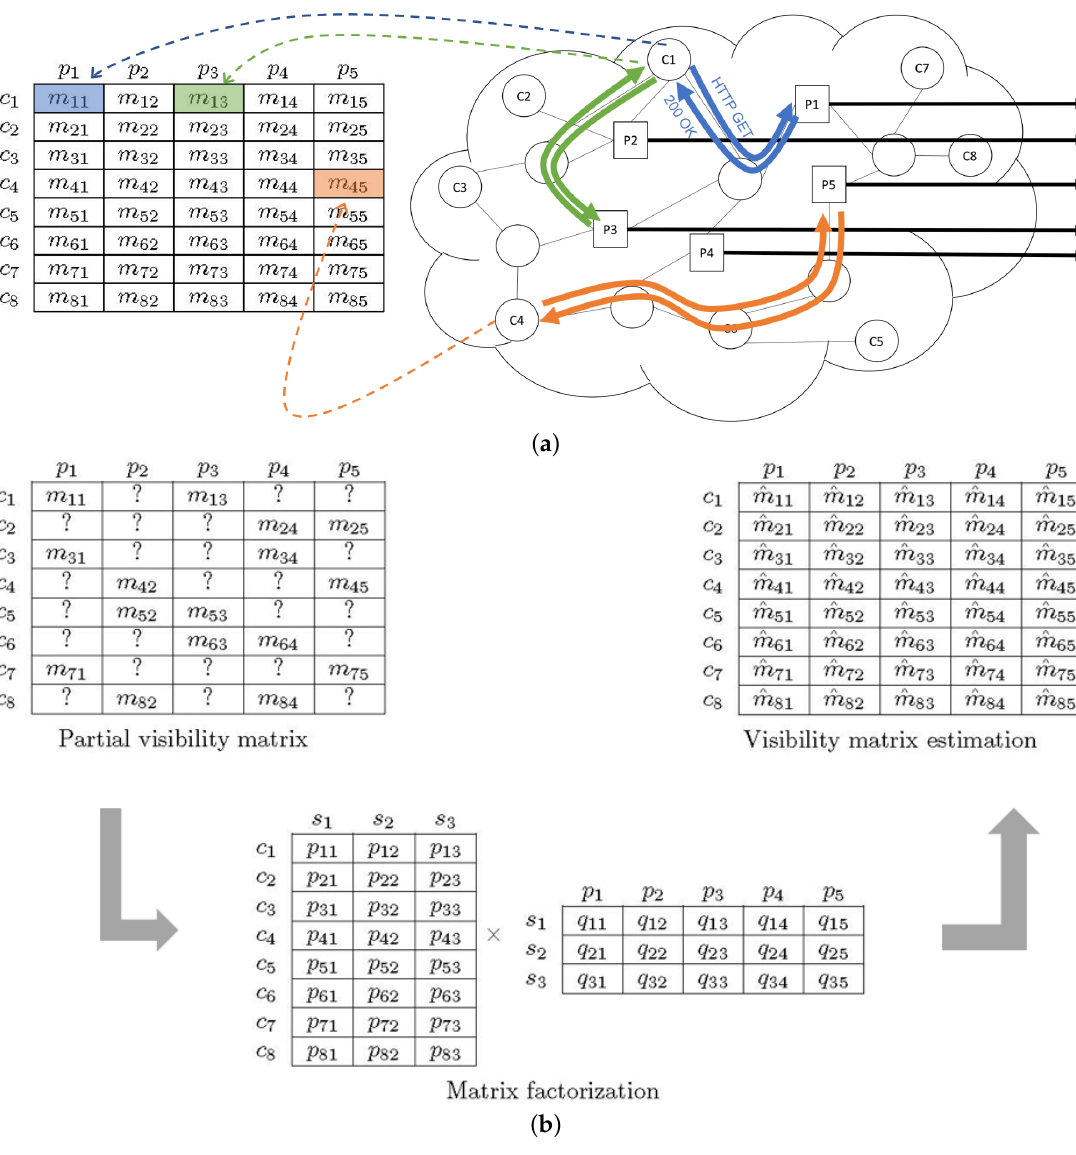
Figure 1. Illustrative representation of the estimation process: ( a ) Response time measurement for some client/proxy pairs, and ( b ) estimation of the full matrix using matrix